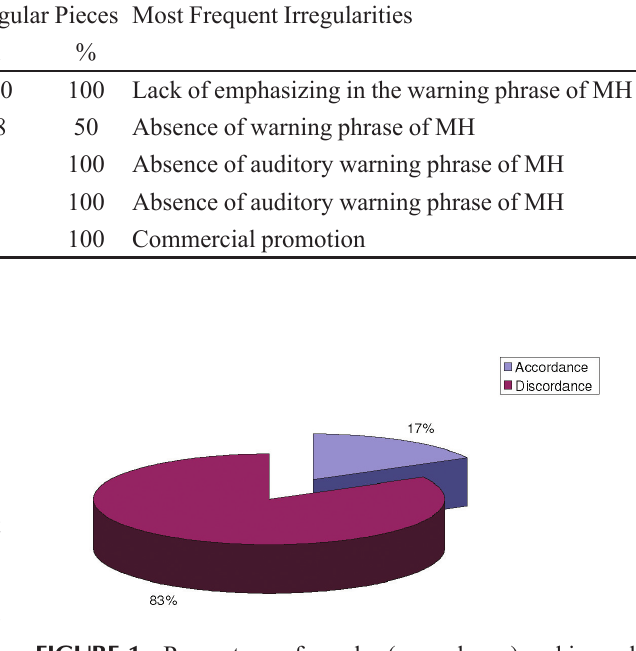
FIGURE 1 - Percentage of regular (accordance) and irregular (discordance) advertisement pieces of infant food concerning RDC #